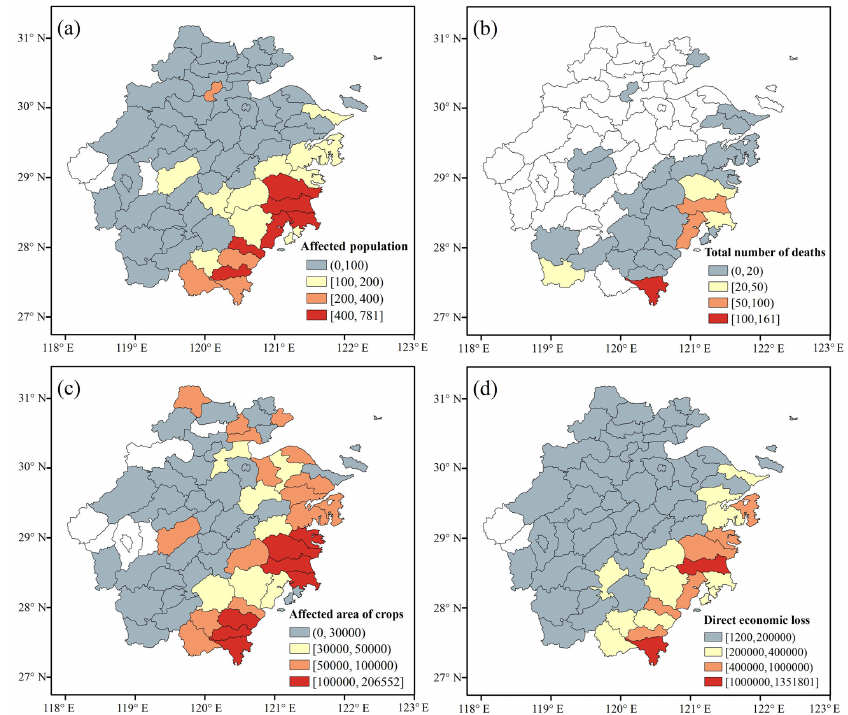
Figure 3. Distribution of typhoon disaster losses in Zhejiang Province from 2004 to 2012. (a) Affected population (millions), (b) total number of deaths (person), (c) area of affected crops (hectares) and (d) direct economic losses (millions of yuan).